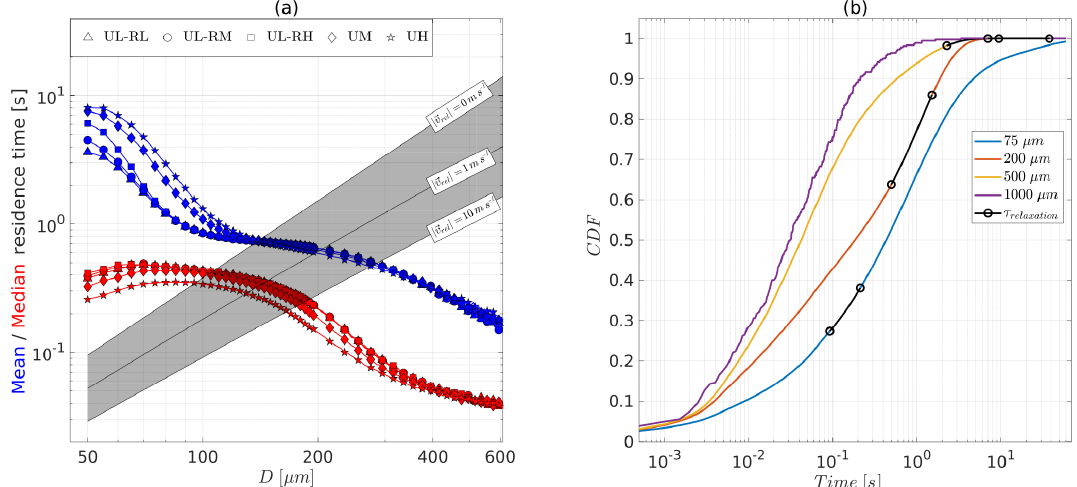
Figure 4. (a) Mean and median particle residence time (PRT) as a function of particle diameter. The plausible values of τ relaxation are represented by the shaded region with trends for three values of | u rel | shown by straight lines. Note that the horizontal axis is logarithmic. (b) Cumulative distribution functions of PRTs for four particle diameters along with a range of plausible τ relaxation values are marked by overlying black curves.